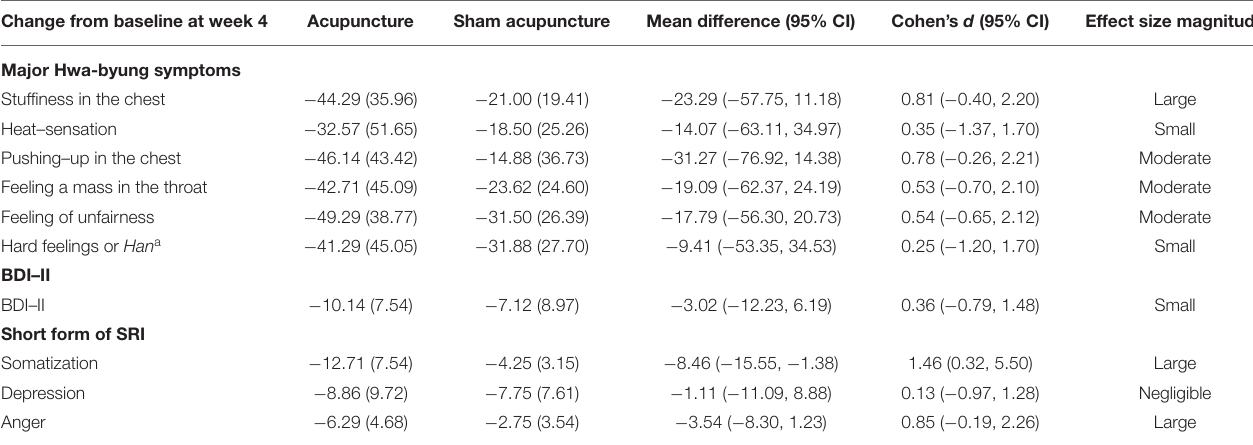
TABLE 2 | The effect size of acupuncture on major Hwa-byung symptoms measured on a 100-mm visual analog scale, BDI-II, and SRI-short form at week 4 (posttreatment). Change from baseline at week 4